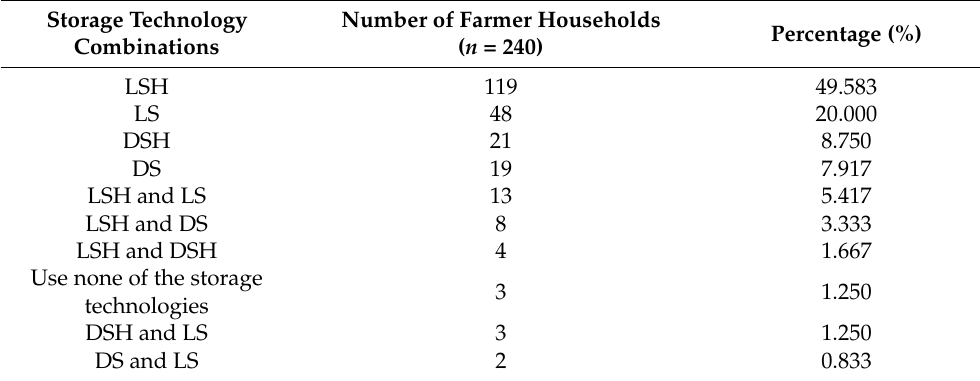
Table 8. Proportion of potato farmers using different storage technology combinations.